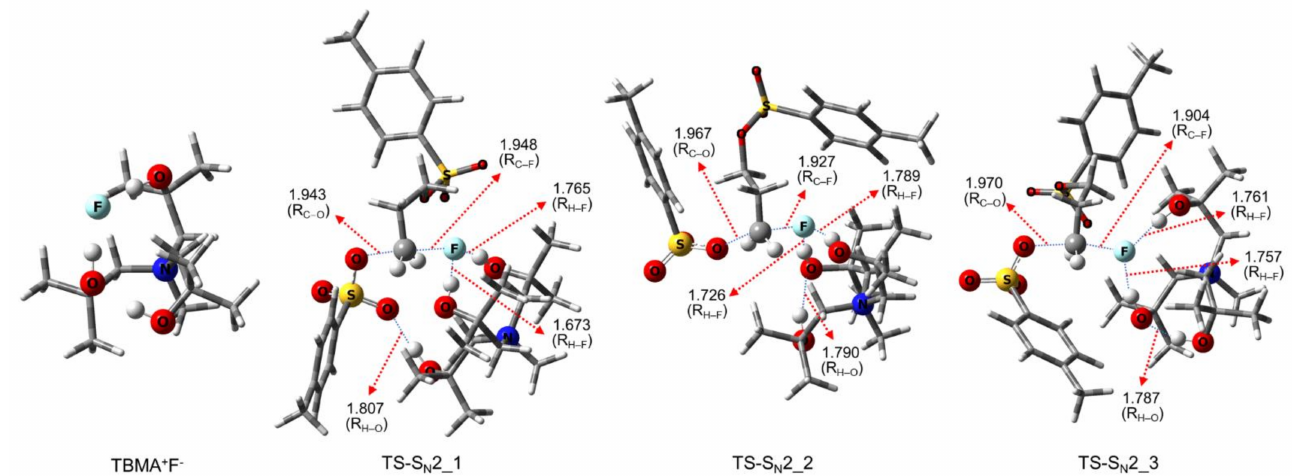
Figure 1. Calculated structures of the free reactant TBMA + F − and the transition states of 18 F- fluorination using TBMA- 18 F in CH 3 CN.